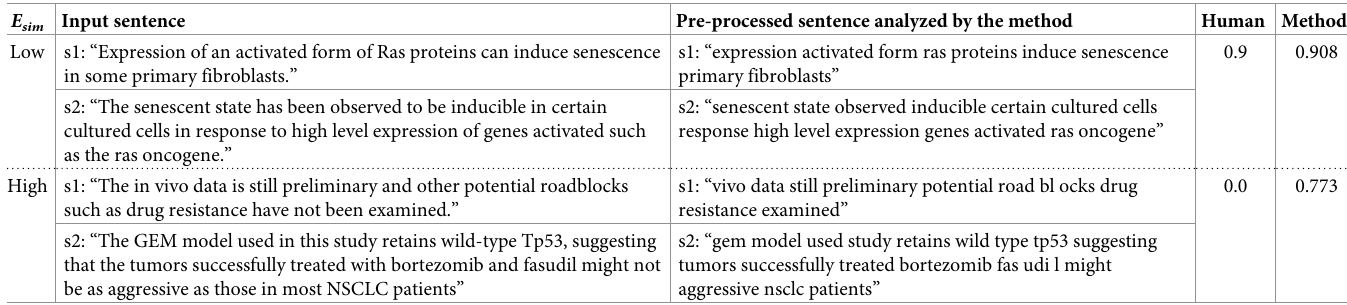
Table 16. Raw and pre-processed sentence pairs obtaining the lowest and highest similarity error E sim together with their corresponding Normalized human similar- ity score (Human) and normalized similarity value (Method) estimated by the OuBioBert (M47) method for the raw and pre-processed sentence pairs with the low- est (L) and highest (H) similarity error E . sim